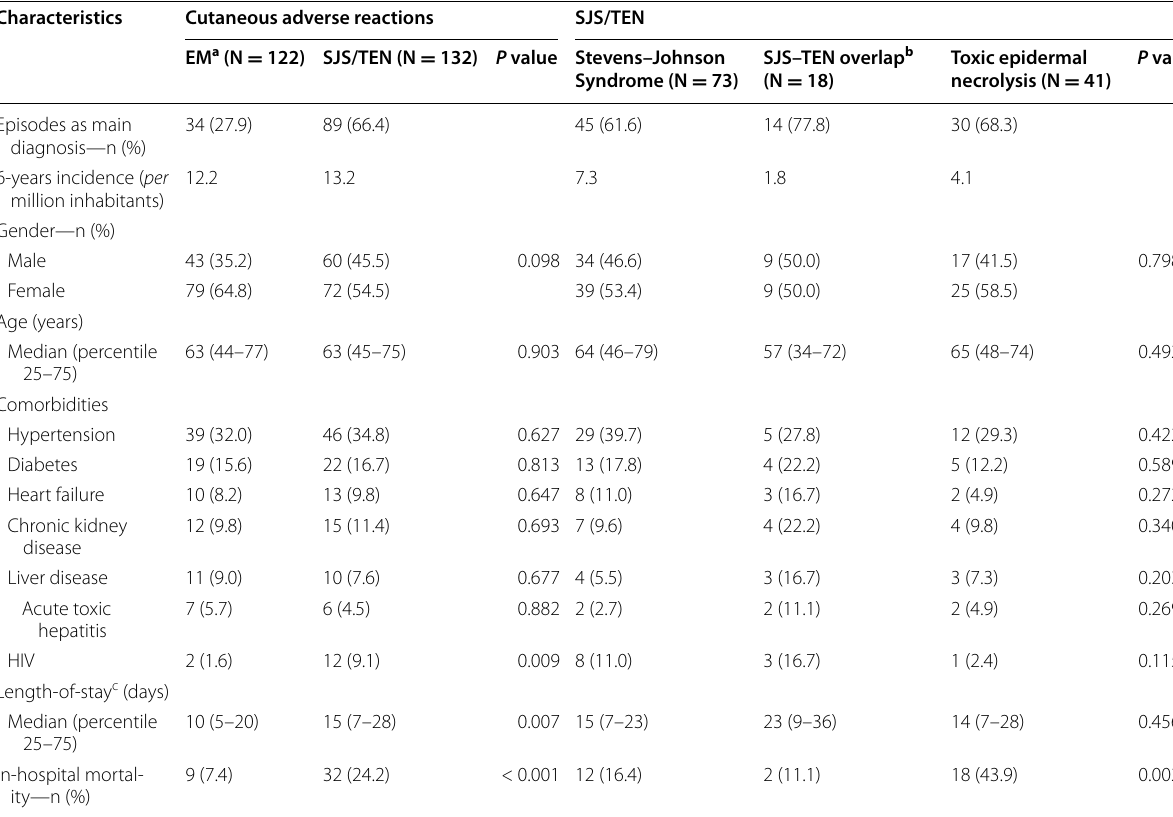
Table 1 Demographic and clinical characteristics of hospitalised patients with an associated diagnosis of erythema multiforme (EM) or Stevens–Johnson syndrome/toxic epidermal necrolysis (SJS/TEN); Mainland Portugal, 2009–2014 ( n 254 =